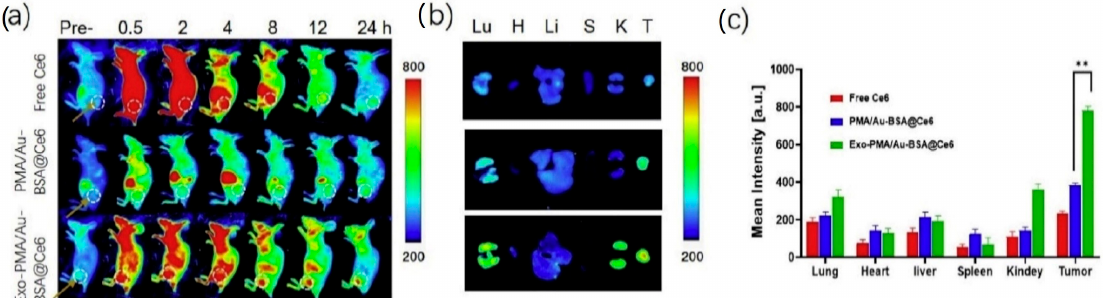
Figure 3. ( a ) Fluorescence imaging of mice bearing MGC-803 tumors intravenously injected with free Ce6, PMA / Au-BSA@Ce 6 or Exo-PMA / Au-BSA@Ce6 nanovehicles, obtained at the designated time points before and after injection in vivo. ( b ) Ex vivo fluorescence pictures of major organs (lung, heart, liver, spleen, and kidney) and tumors harvested from mice intravenously injected with samples of free Ce6, PMA / Au-BSA@Ce6 or Exo-PMA / Au-BSA@Ce6 nanovehicles after 24 h. The results are presented as mean ± SD (n = 5). ( c ) Quantitative biodistribution of free Ce6, PMA / Au-BSA@Ce6 or Exo-PMA / Au-BSA@Ce6 nanovehicles based on the average fluorescence intensity from major organs and tumor (n = 5). ** = p < 0.05 as specified in the Experimental section. Reproduced from [81] (permission pending).